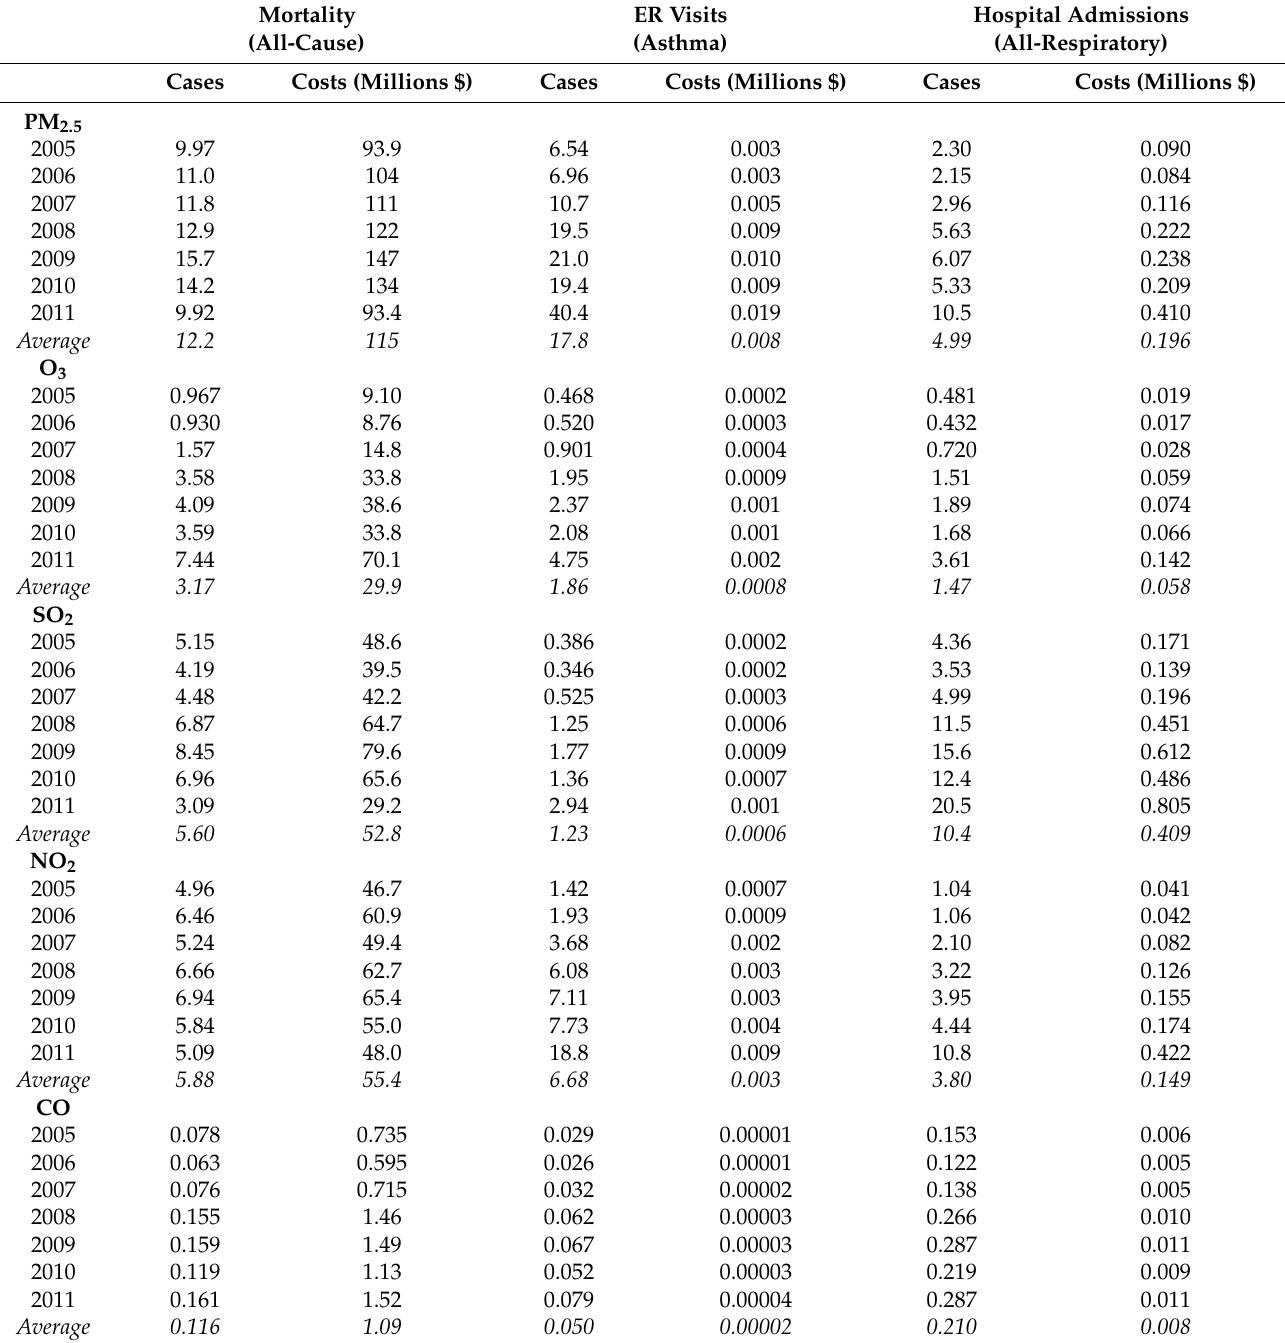
Table 3. Aggregate MPB mortality and morbidity impacts and costs by pollutant type and year for Western US, 2005–2011.